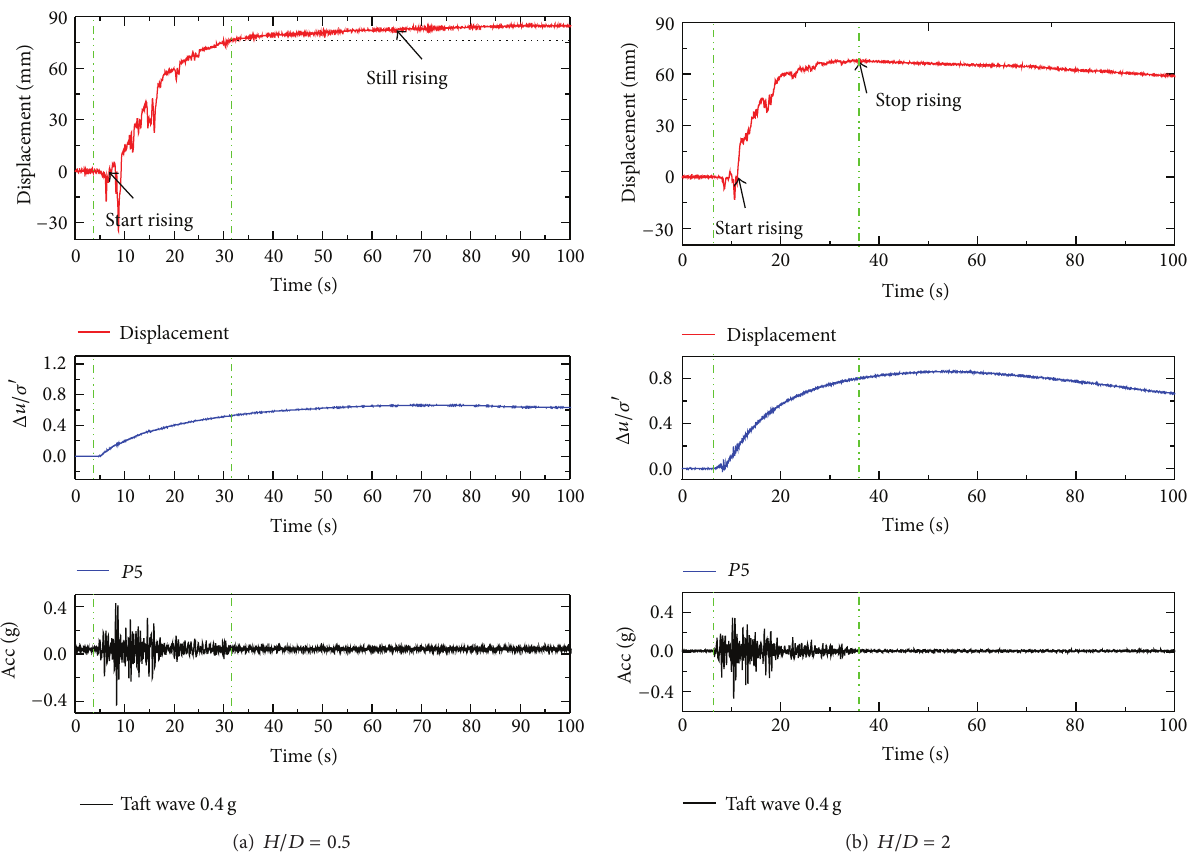
Figure 7: Uplift displacement of pipe 1# at different depth under Taft